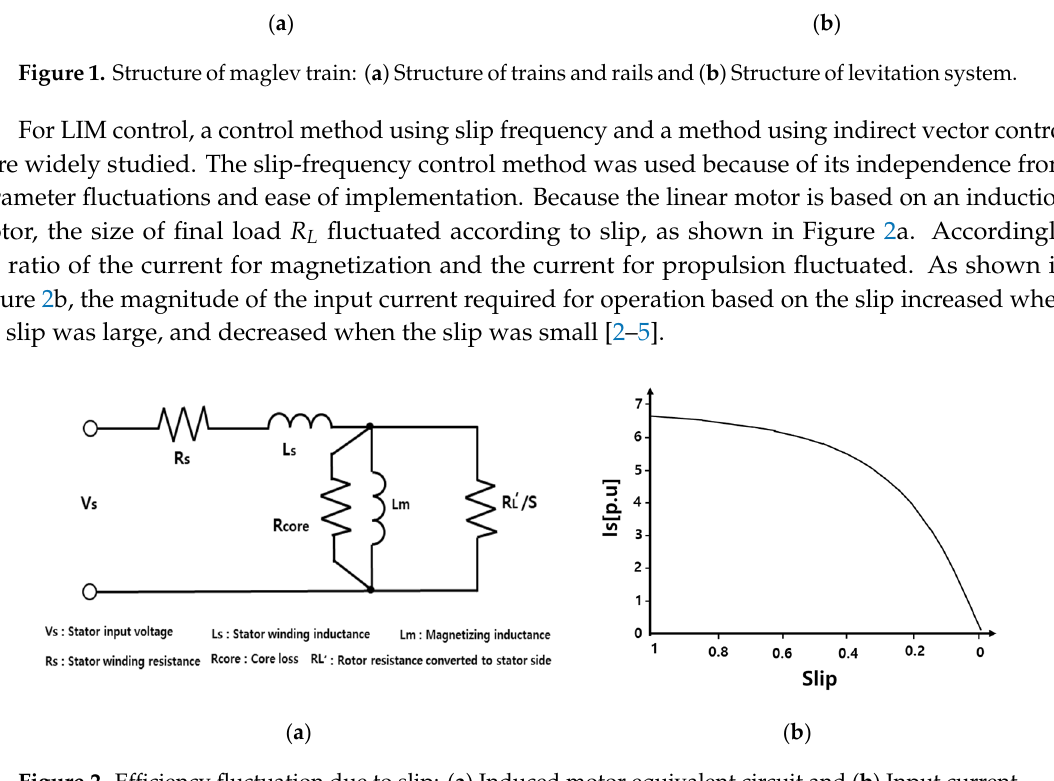
Figure 2. Efficiency fluctuation due to slip : ( a ) Induced motor equivalent circuit and ( b ) Input current and slip .